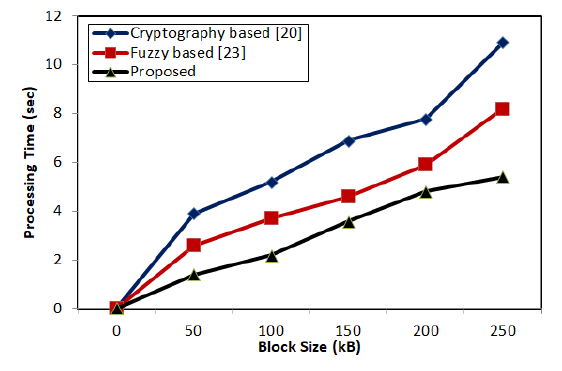
Figure 5. Processing time w.r.t block size(kb)